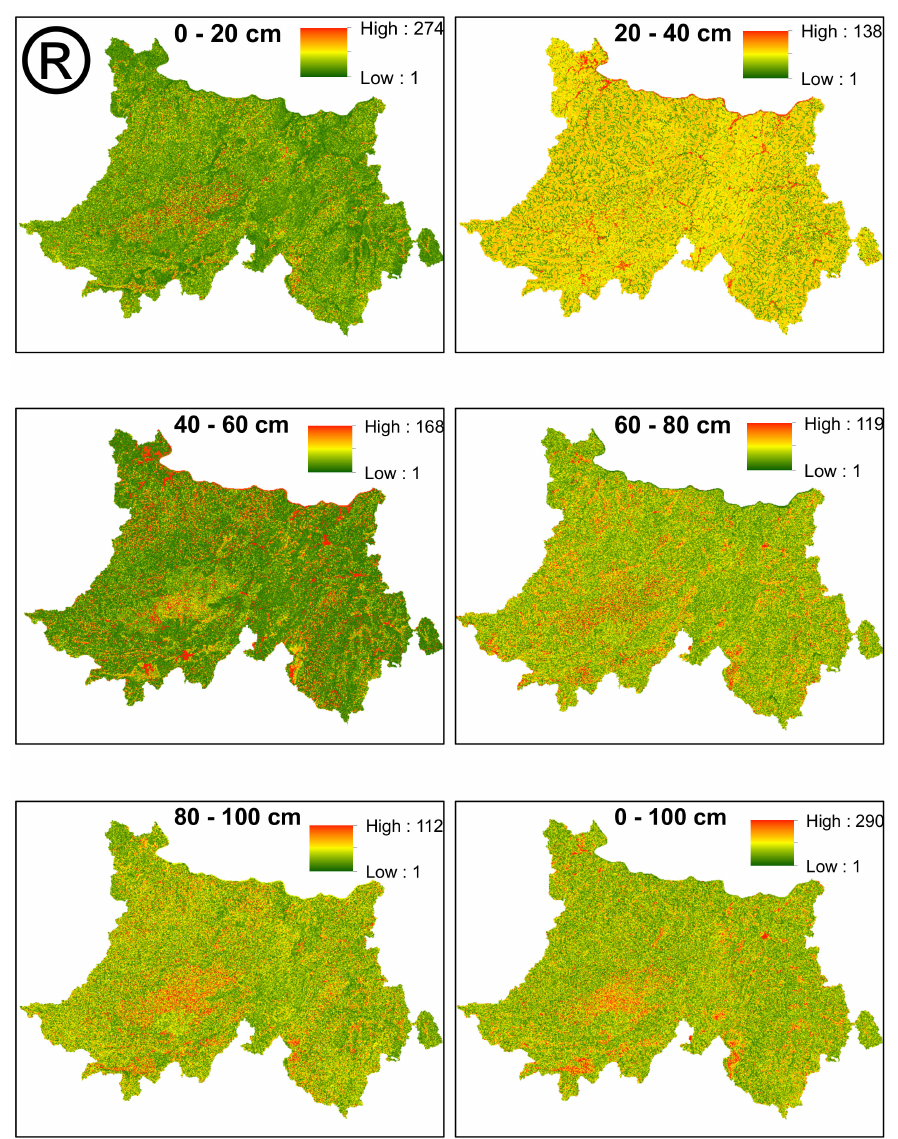
Figure 3. Mean prediction of soil Cd concentrations ( µ g mg − 1 ) at different depths with the selected best model from 10